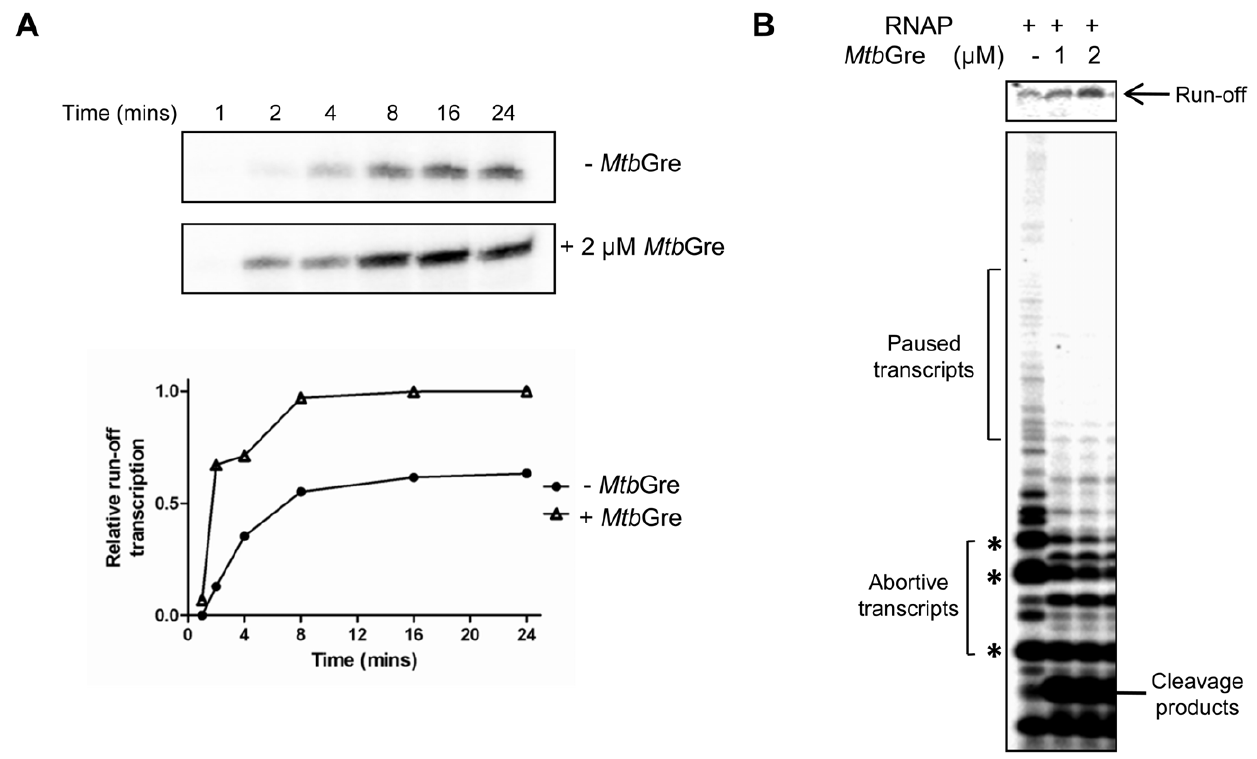
Figure 4. Effect of Mtb Gre factor on promoter clearance and abortive transcription. ( A ) Promoter clearance assays were carried out in the absence (- N -) or presence (- D -) of 2 m M Mtb Gre. Transcripts were resolved on an 8% urea-PAGE and 109 nt long run-off transcripts were quantified using Image Guage (Fuji Film) and plotted (lower panel). The intensity of the bands was normalized against the amount of run-off transcript produced after 24 mins in presence of Mtb Gre. ( B ) Mtb Gre reduces abortive transcript level. In this assay, transcription reactions were carried out in the absence and presence of 1 m M and 2 m M Mtb Gre. The reactions were resolved on a 20% urea-PAGE to visualize abortive transcripts (marked by